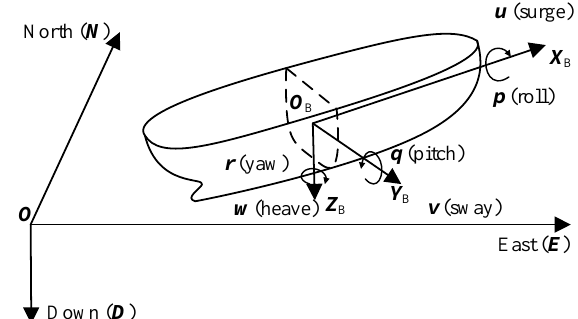
Figure 3. Coordinate system